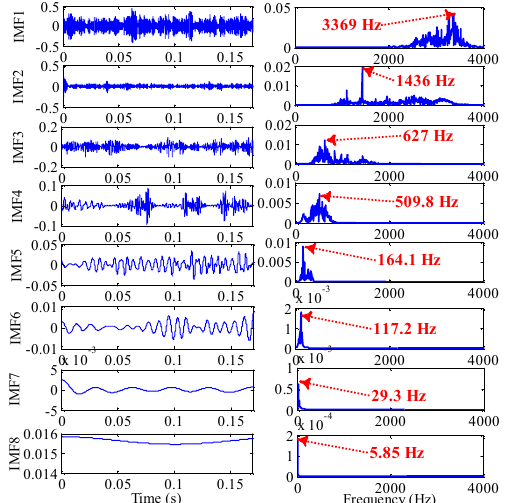
Figure 22. The IMFs of rolling element obtained by the optimized TVF-EMD based on IGOA.